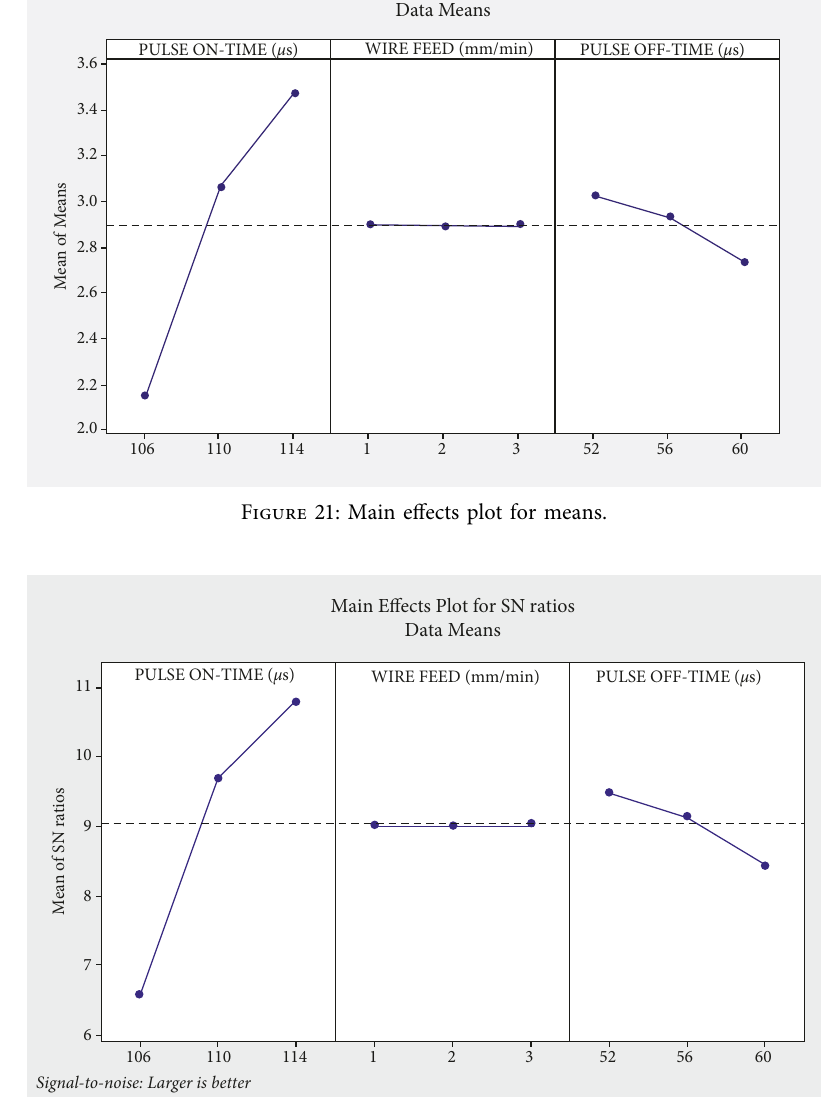
Figure 22: Main effects plot for SN ratios. Table 12: Response table for means for